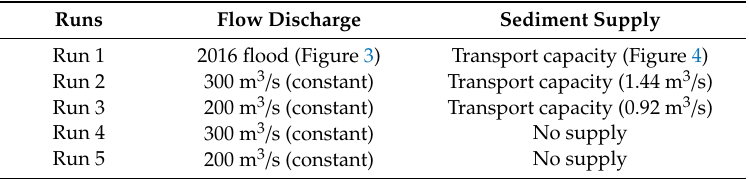
Table 1. Calculation